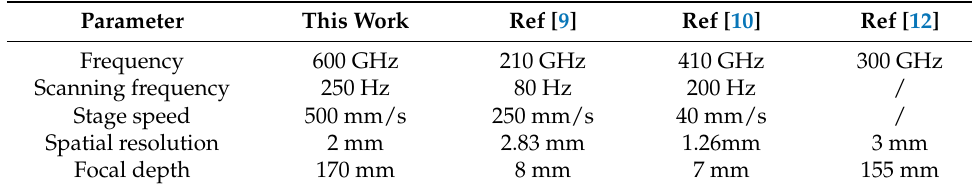
Table 1. Comparison of this work with other THz imaging